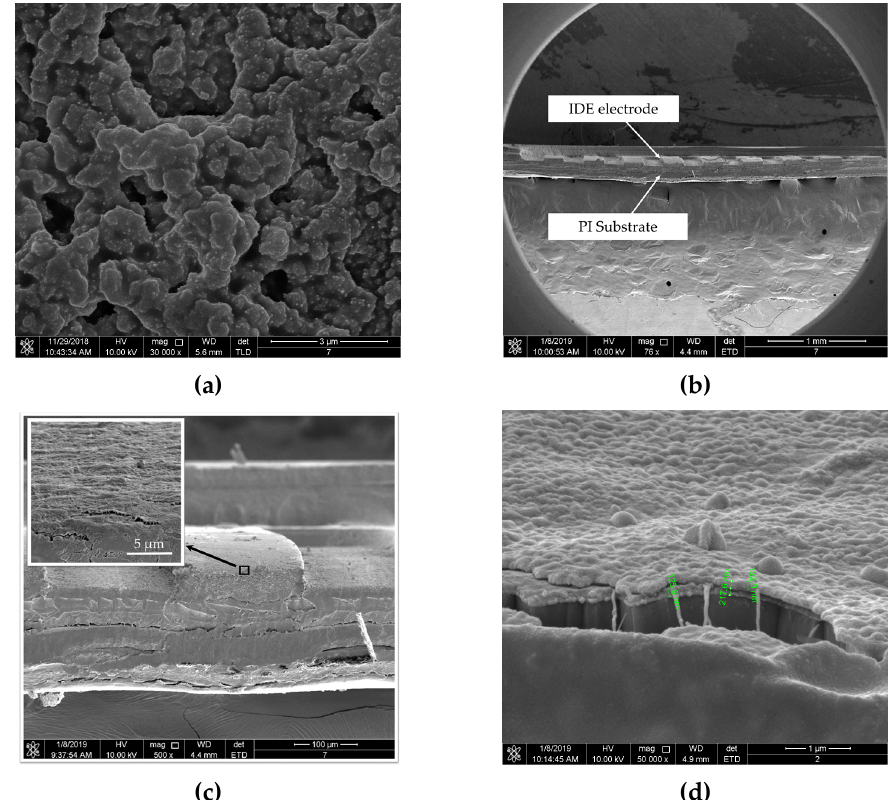
Figure 9. SEM morphologies of ( a ) top-view of PEG/MWCNTs composite film, ( b ) cross-section micrograph of the gas sensor, ( c ) close view of the interface between electrode and PEG/MWCNTs composite film, ( d ) close view of PEG/MWCNTs composite film.